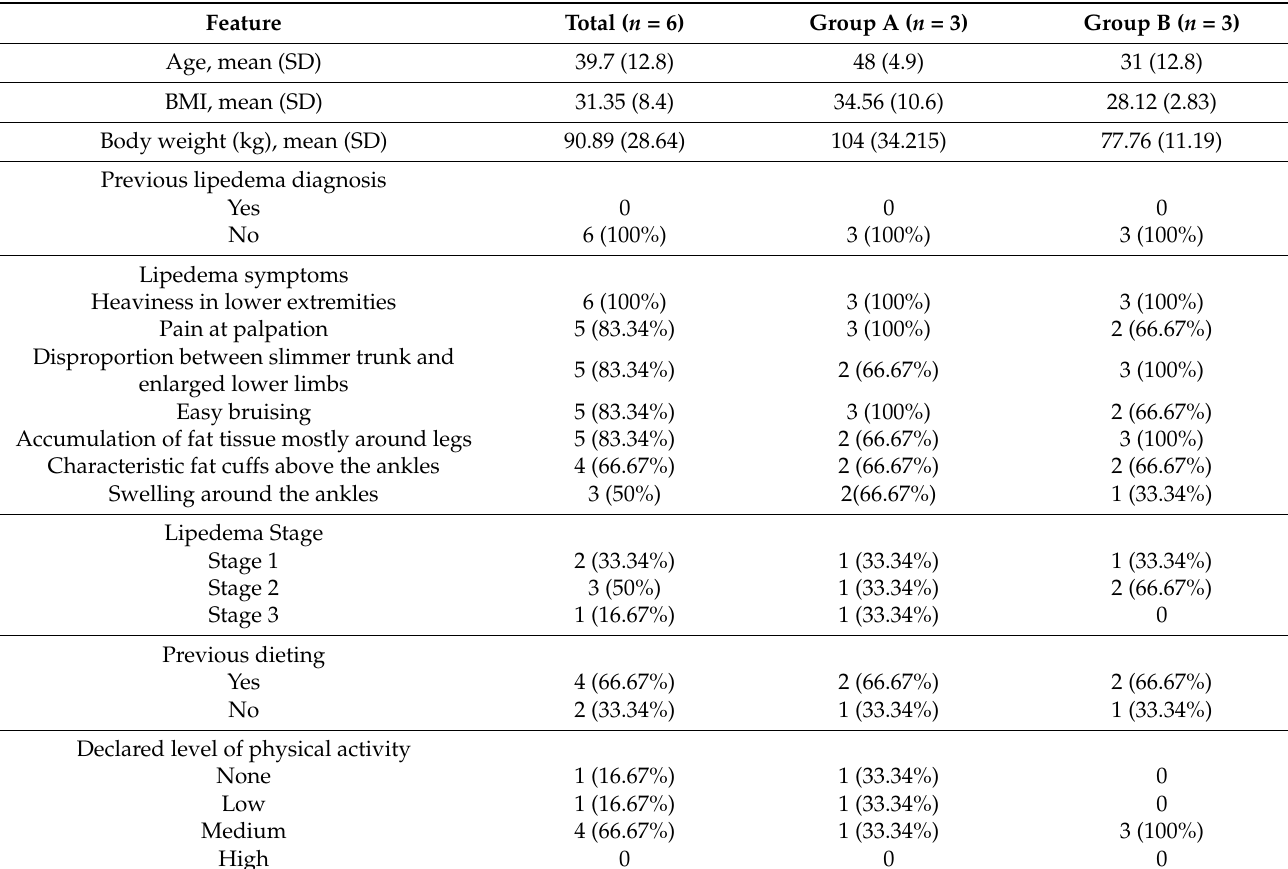
Table 1. Characteristics of participants in groups A and B.